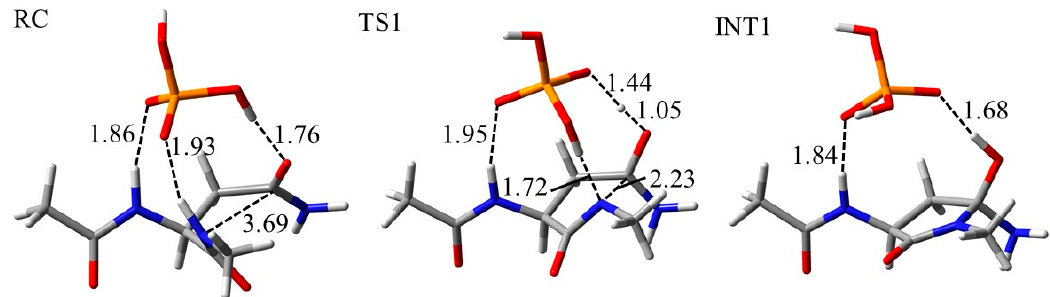
Figure 10. Optimized geometries of the cyclization step for the anti conformation in the phosphate- catalyzed reaction. The carbon, nitrogen, oxygen, and phosphorus atoms are illustrated in gray, blue, red, and orange, respectively. Selected interatomic distances are in units of Å.